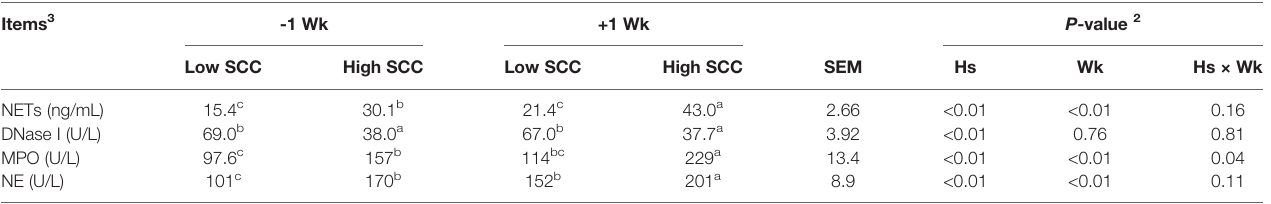
TABLE 2 | Serum concentrations of NET-related indices in dairy cows with low and high somatic cell counts (SCCs) 1 at Week 1 pre- (-1 Wk) and postpartum (+1 Wk). Items 3 -1 Wk +1